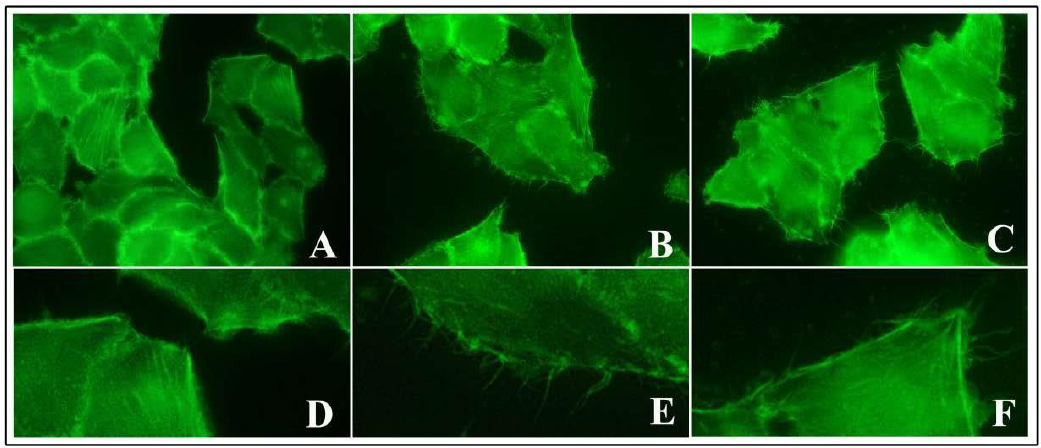
Figure 6. Actin phalloidin staining of HT-29 cells pre-treated with TiO 2 NPs. Representative images of control untreated cells ( A , D ), pre-exposed cells to 1 μ g/cm 2 ( B , E ), and 20 μ g/cm 2 ( C , F ) at 6 h of NP treatment. Magnification: 400× for ( A – C ) and 4200× for ( D – F ).